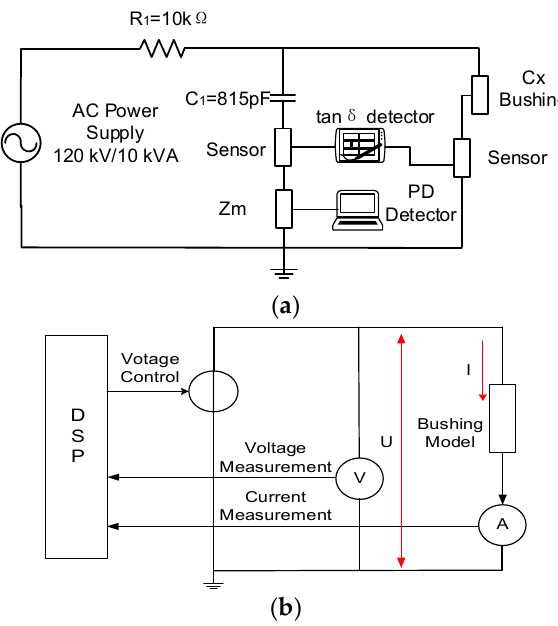
Figure 2. Test circuit of partial discharge (PD), tan δ , and Frequency Domain Spectroscopy (FDS). ( a ) The circuit of PD and tan δ measurement; ( b ) FDS measurement. DSP: digital signal processing